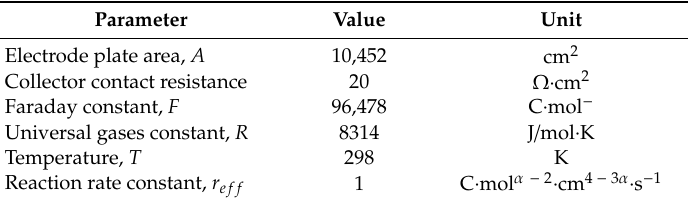
Table 2. Cell model parameters